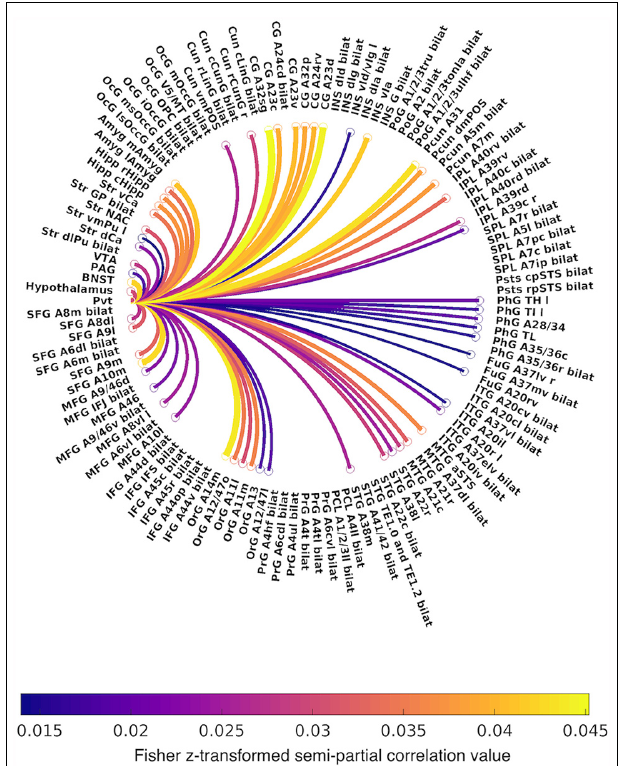
FIGURE 3 | Circular graph summarizing positive functional connectivity of the PVT, controlling for the rest of the thalamus. Lines are color-coded by Fisher z -transformed semi-partial correlation values. Abbreviations: A, area; CG, cingulate gyrus; Cun, cuneus; d, dorsal; IFG, inferior frontal gyrus; INS, insula; IPL, inferior parietal lobule; ITG, inferior temporal gyrus; FuG, fusiform gyrus; l, lateral; m, medial; MFG, middle frontal gyrus; MTG, middle temporal gyrus; OcG, occipital gyrus; OrG, orbital gyrus; PrG, precentral gyrus; PCL, paracentral lobule; Pcun, precuneus; PhG, parahippocampal gyrus; PoG, postcentral gyrus; SFG, superior frontal gyrus; SPL, superior parietal lobule; STG, superior temporal gyrus; Str, striatum; v,